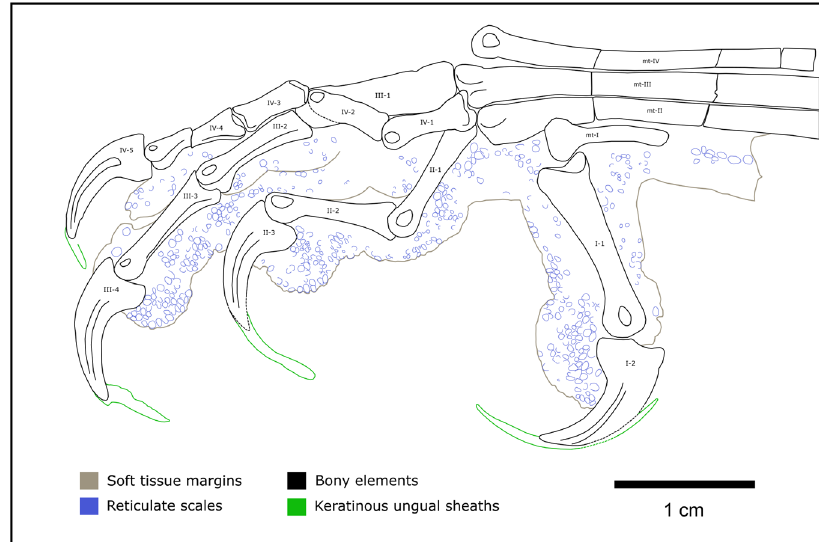
Fig. 5 | Complete, articulated left pes of Sapeornis 41HIII0405. Interpretive drawing, where solid lines indicate preserved structural boundaries, and dashed lines represent assumed or completed boundaries. Based on a photograph by S. Abramowicz in